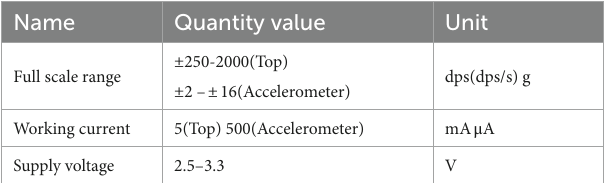
TABLE 2 MPU-6000 main performance.